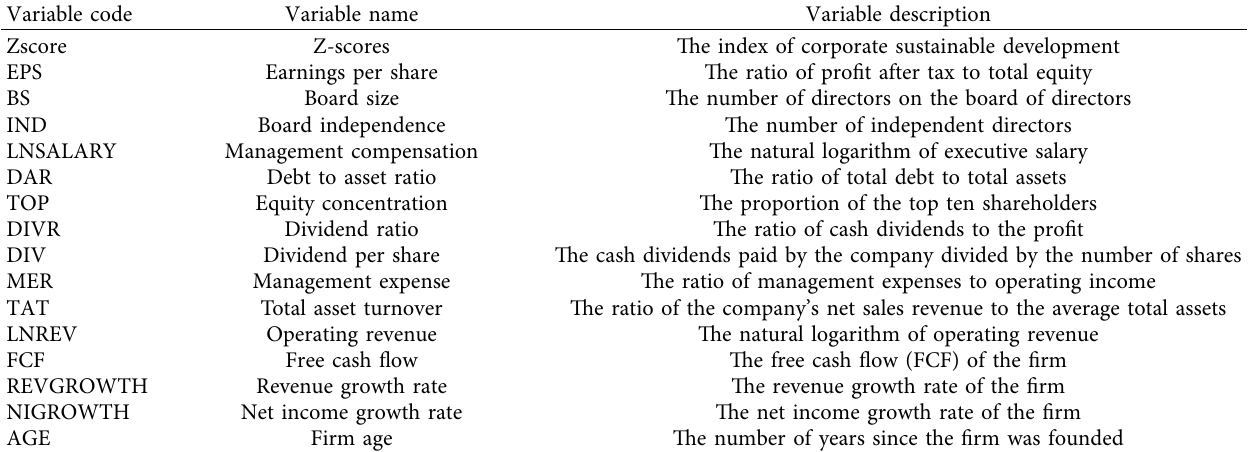
Table 1: The variables used in the